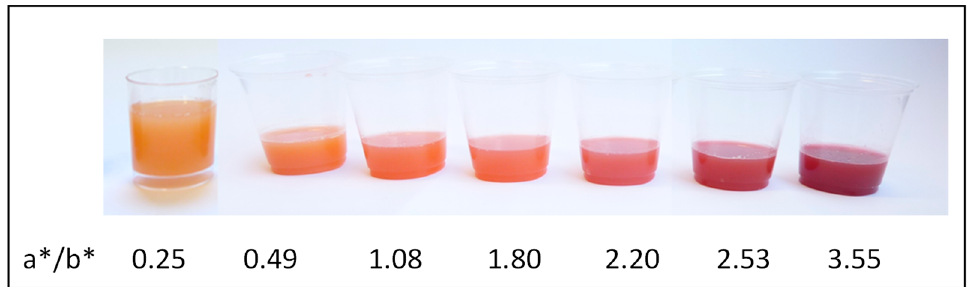
Figure 3 . Frequency distribution of the pulp colour (a*/b* values of juice) of ‘Sanguinelli’ blood or- anges grouped according to rind pigmentation (P1—slight, P2—medium, P3—intense, P4—very in- tense). Each group of intensity per orchard consisted of 50 individually analysed fruits.